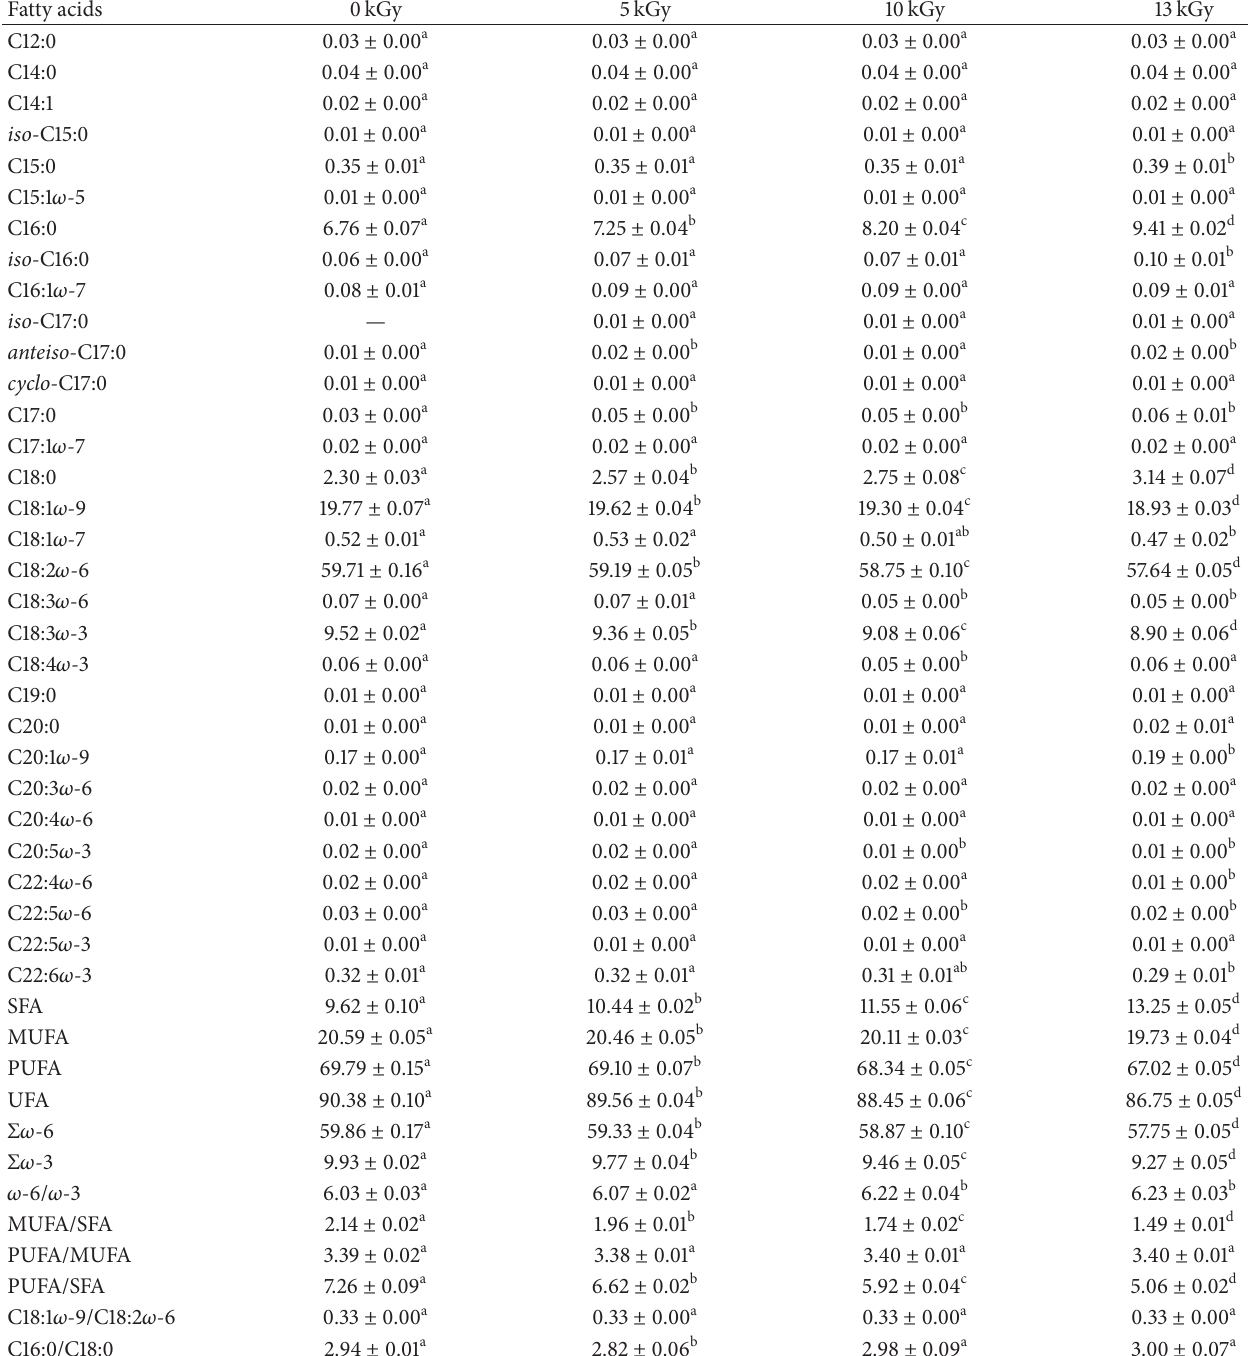
Table 2: Fatty acids composition % of (Total Fatty Acids) TFA in total lipids of non-irradiated and irradiated walnuts packaged in